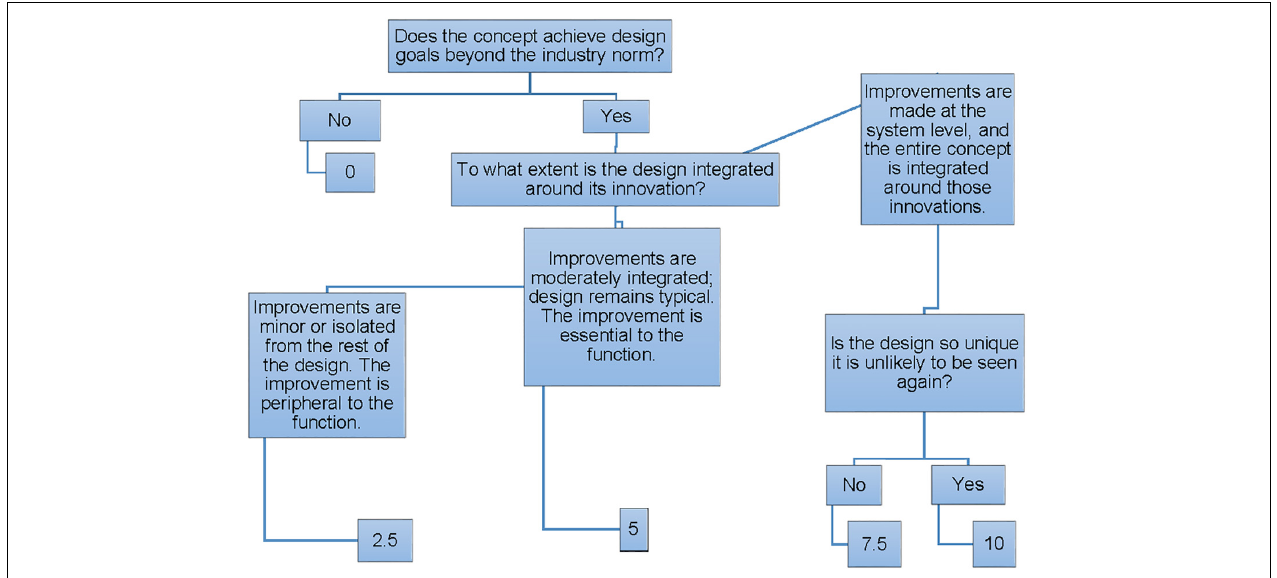
FIGURE 1 | The decision tree for originality assessment in design (DTOAD). © Kershaw et al., 2015, reproduced with